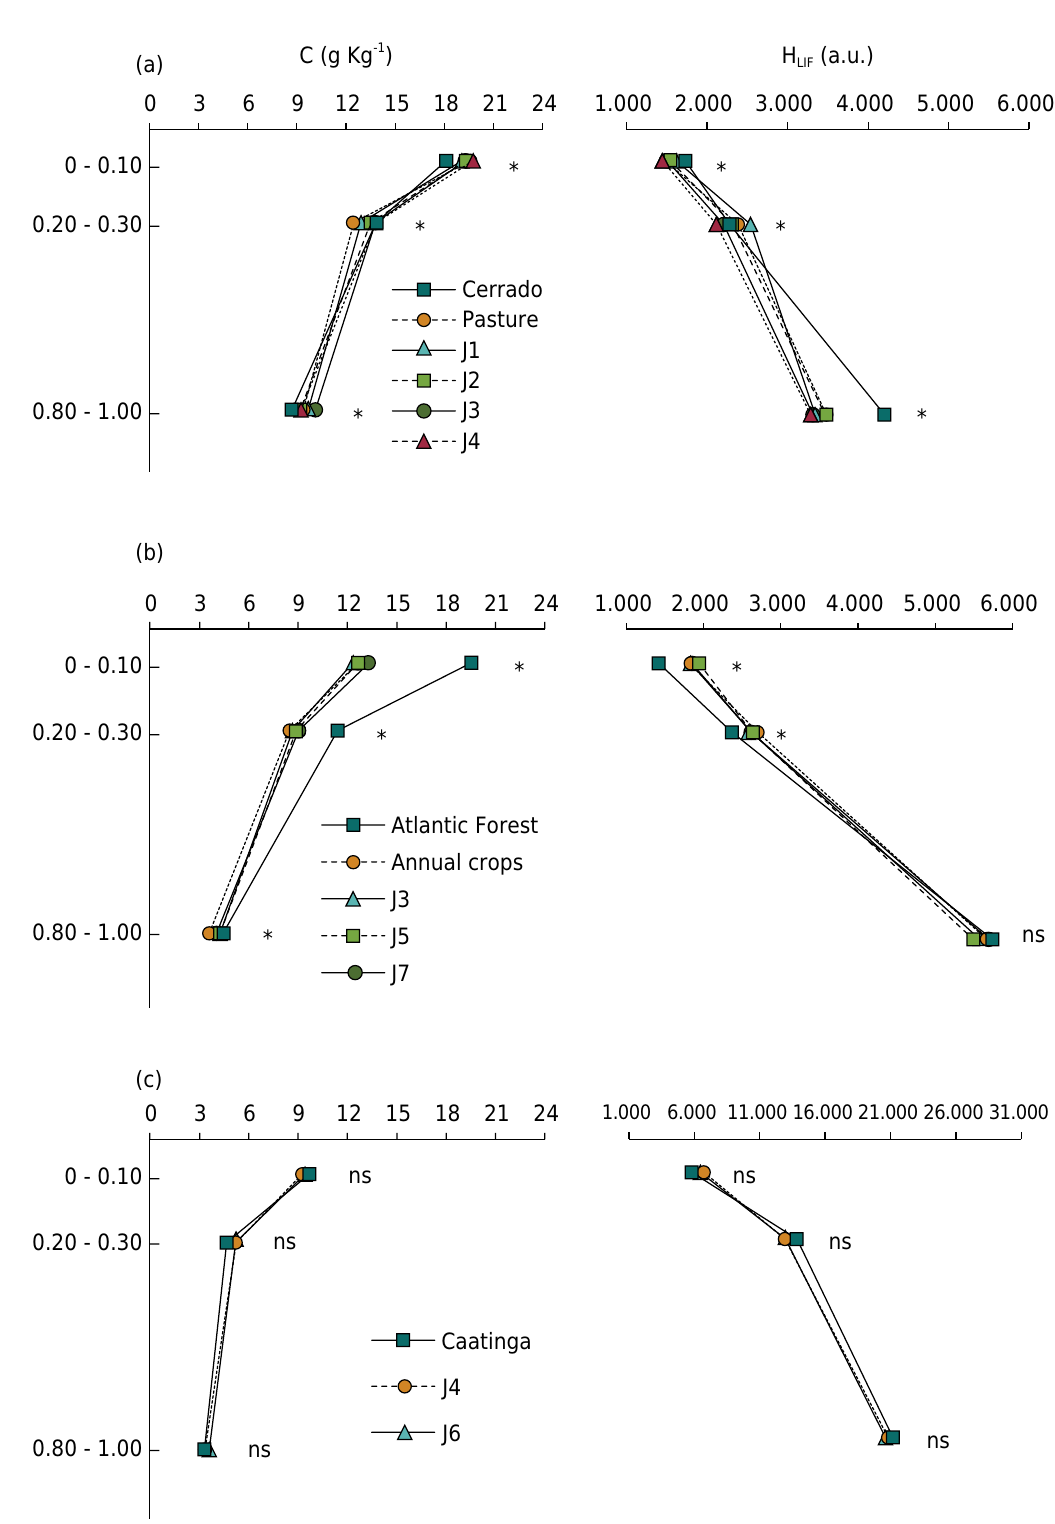
Figure 2. Carbon content and soil organic matter humification index (H LIF ) in soil samples from depths of 0.00-0.10, 0.20-0.30, and 0.80-1.00 m in areas under different uses in Planaltina-DF (a), Dourados-MS (b), and Araripina-PE (c), Brazil. The areas evaluated refer to cultivation with Jatropha spp. over 1 (J1), 2 (J2), 3 (J3), 4 (J4), 5 (J5), 6 (J6), and 7 (J7) years, pasture, annual crops, and areas with native vegetation ( Cerrado , Atlantic Forest, and Caatinga ). * and ns: significant and not significant, respectively, by the Tukey test